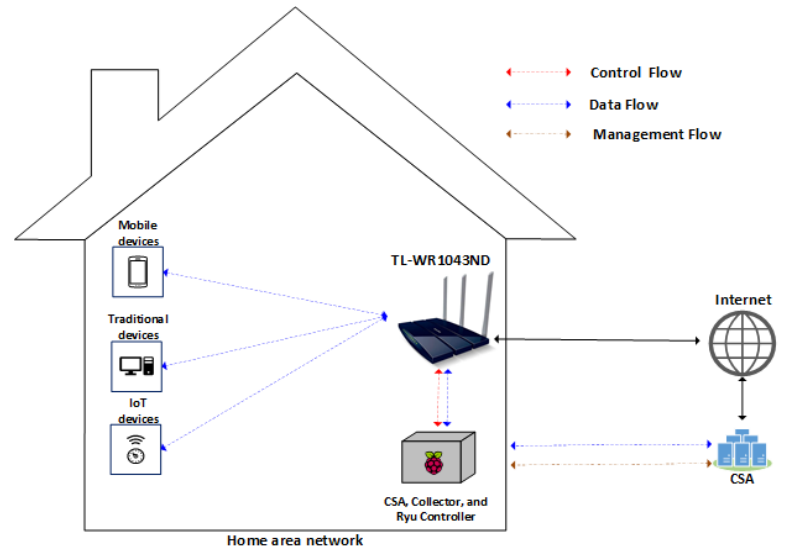
Figure 7. Experimental deployment of a home area network. The HSU is depicted as a junction of a TL-WR1043ND router and a Ryu